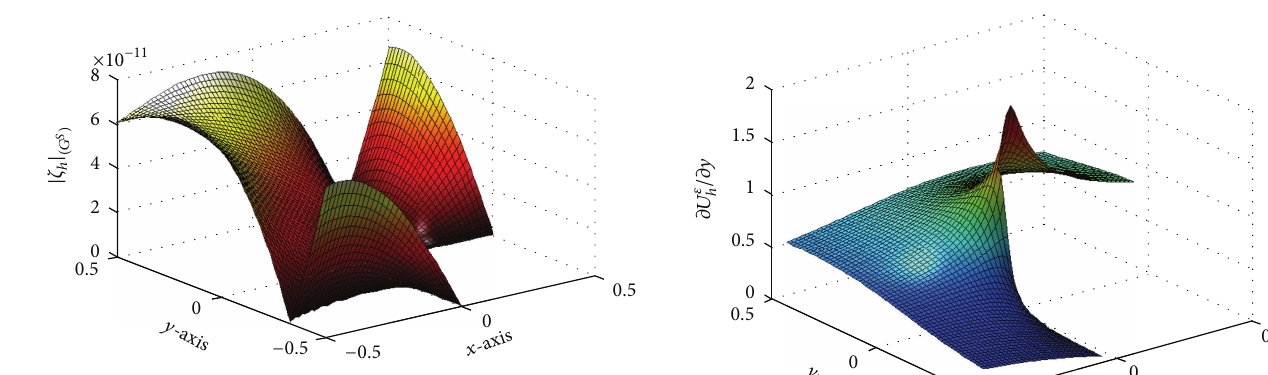
Figure 7: The error function in “singular” part when 𝜀 = 5 × 10 −13 .